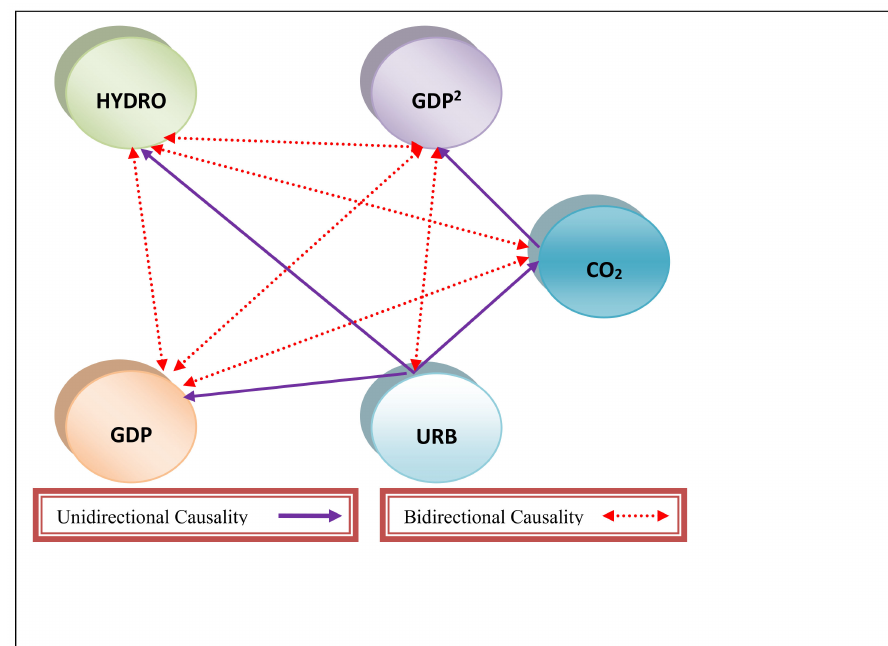
Figure 4. Graphical causality